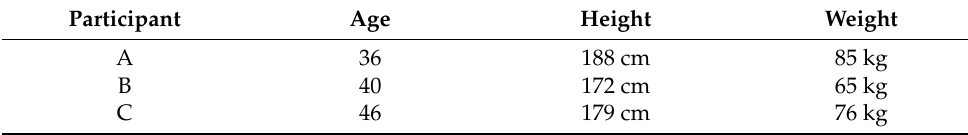
Table 3. Characteristics of